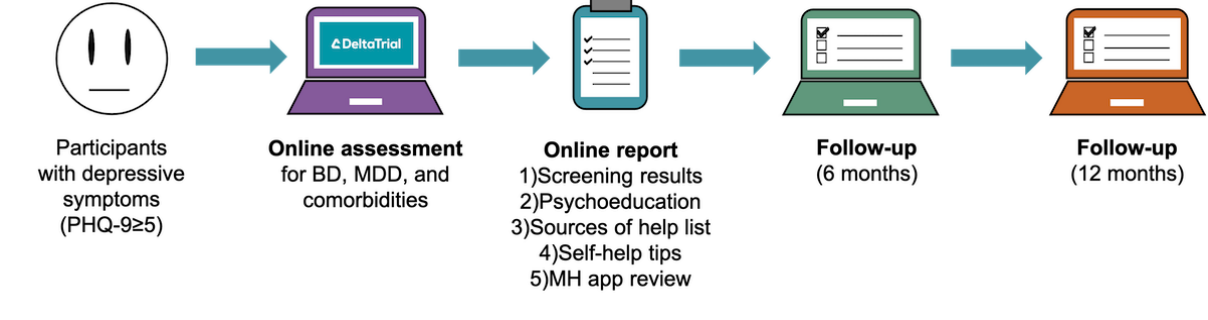
Figure 1. Outline of the Delta Study. Participants displaying depressive symptoms completed a web-based psychiatric assessment on the Delta Study website. The questionnaire asked about demographics, medical history, substance use, and personality, and screened for mood and other comorbid disorders using an adaptive, nonlinear question flow. Upon questionnaire completion, participants were sent a brief report containing their results, personalized psychoeducation, and a list of relevant sources of help (1-3 in the middle panel). Participants could also access a list of self-help tips and existing mental health apps (4-5 in the middle panel) on the Delta Study website. After 6 and 12 months, participants were asked to complete a brief web-based follow-up questionnaire. BD: bipolar disorder, MDD: major depressive disorder, MH: mental health, PHQ-9: Patient Health